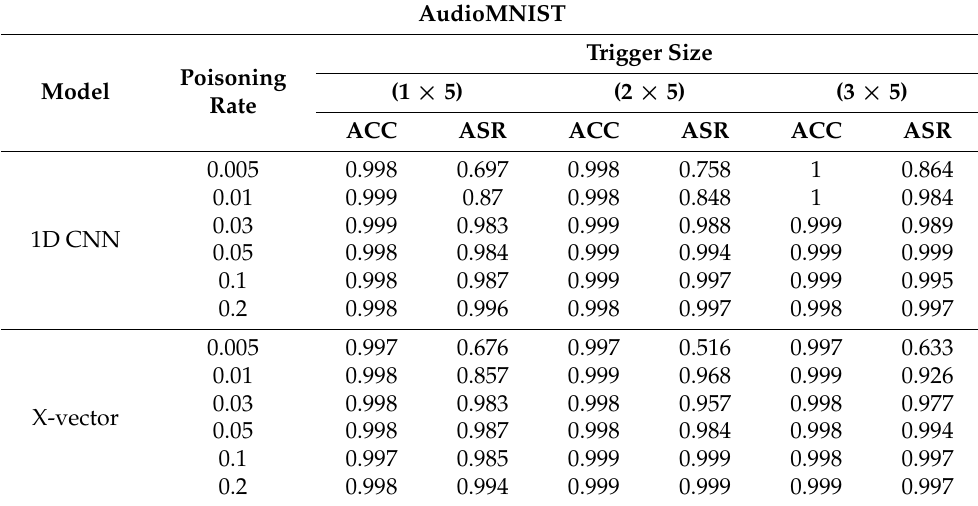
Table 3. The results of the accuracy and attack success rate for the AudioMNIST dataset.